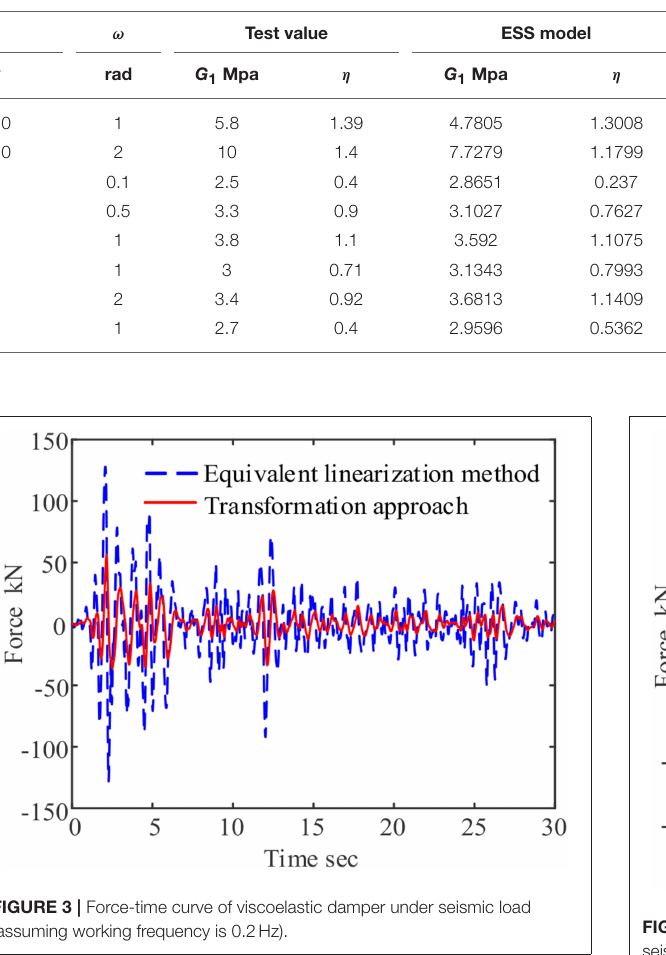
So based on the assumptions, the storage modulus G 1 = 5.5113 × 10 6 Pa, Loss factor η = 1.2998, and the time history curve of force and force-displacement curves of the damper are plotted as shown in the blue dashed lines of Figures 3 , 4